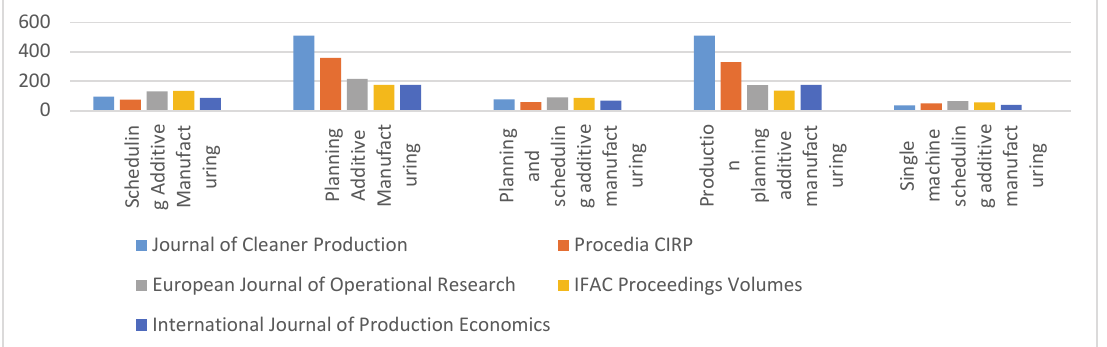
Fig. 3. The number of papers for each research theme for the main journals of interest